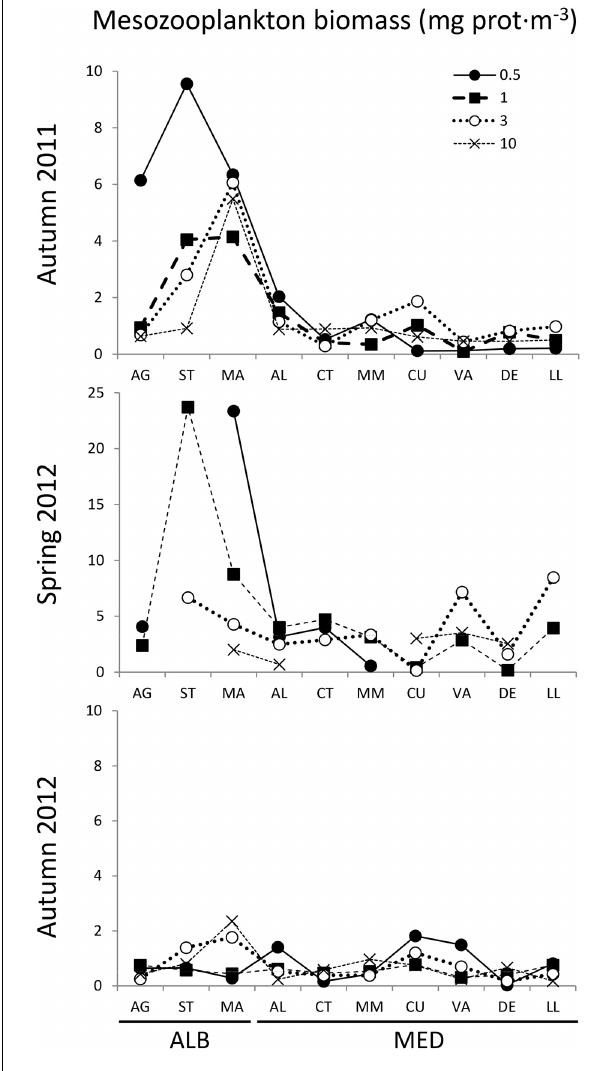
autumn 2011, spring 2012, and autumn 2012. Transect codes as in Figure 1 . Note differences in the y -axis scale among